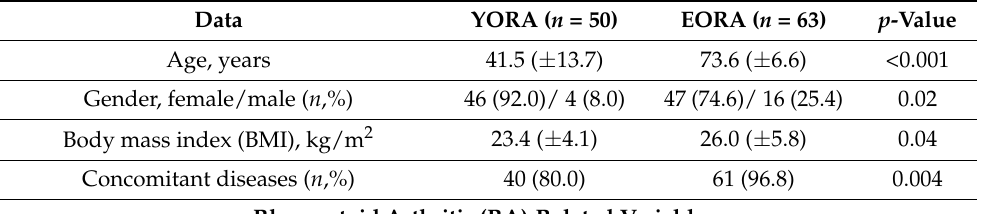
Table 1. Comparison of clinical data in patients with and young-onset rheumatoid arthritis (YORA) and elderly-onset rheumatoid arthritis